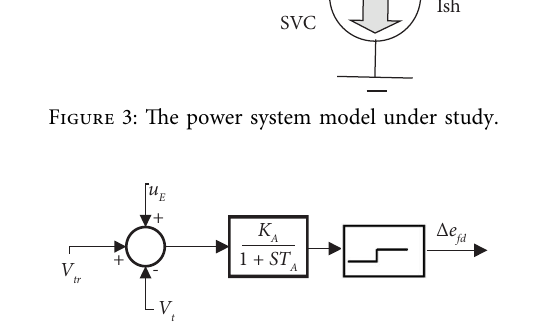
Figure 4: Te exciter system model. Table 1: Te synchronous generator parameters.